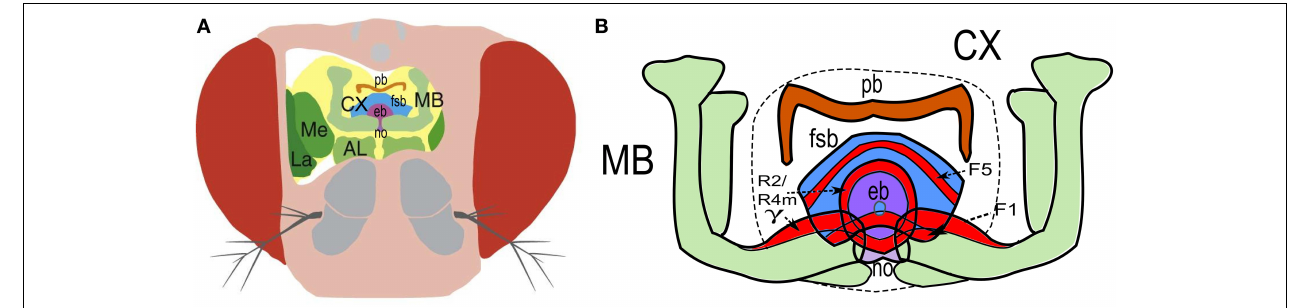
orange), the fan-shaped body (fsb; blue), the ellipsoid body (eb; magenta) and the noduli (no; purple). Adapted from Niven (2010) with permission. (B) Enlargement of the central part of the brain showing the neuropiles and their substructures involved in visual learning (highlighted in red), as the F1 and F5 neurons extending branches in the fan-shaped body, the R2 and R4m ring neurons located in the ellipsoid body, and the MBs